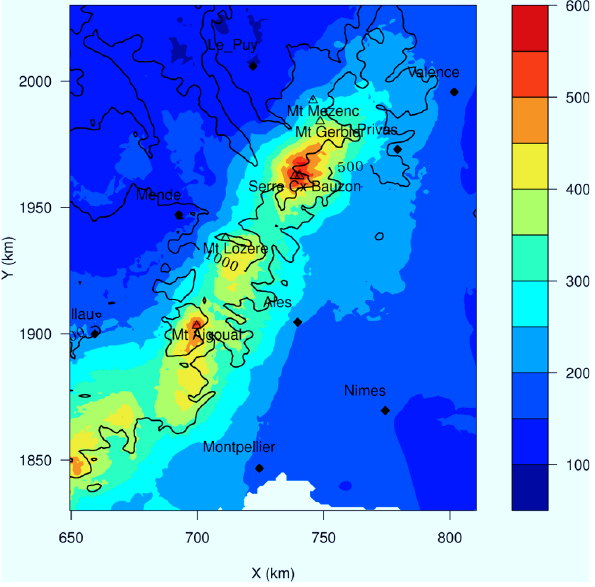
Fig. 8. 100-yr return levels estimated by RS3 on the C´evennes- Vivarais data (mm).